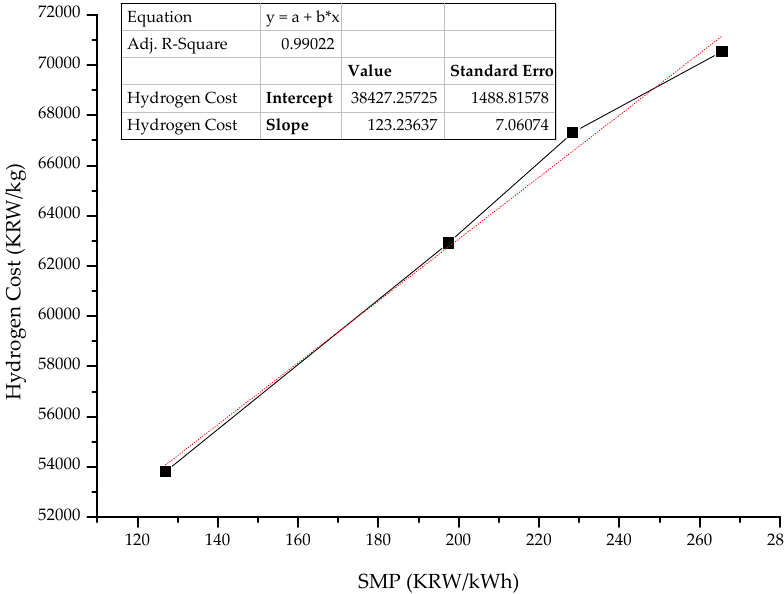
Figure 11. Correlation between SMP and hydrogen cost *. * x -axis: SMP (KRW/kWh), y -axis: Hydrogen Cost (KRW/kg). Solid line: y -values connecting line, Dot line: Regression line. Table 29. Summary of sensitivity